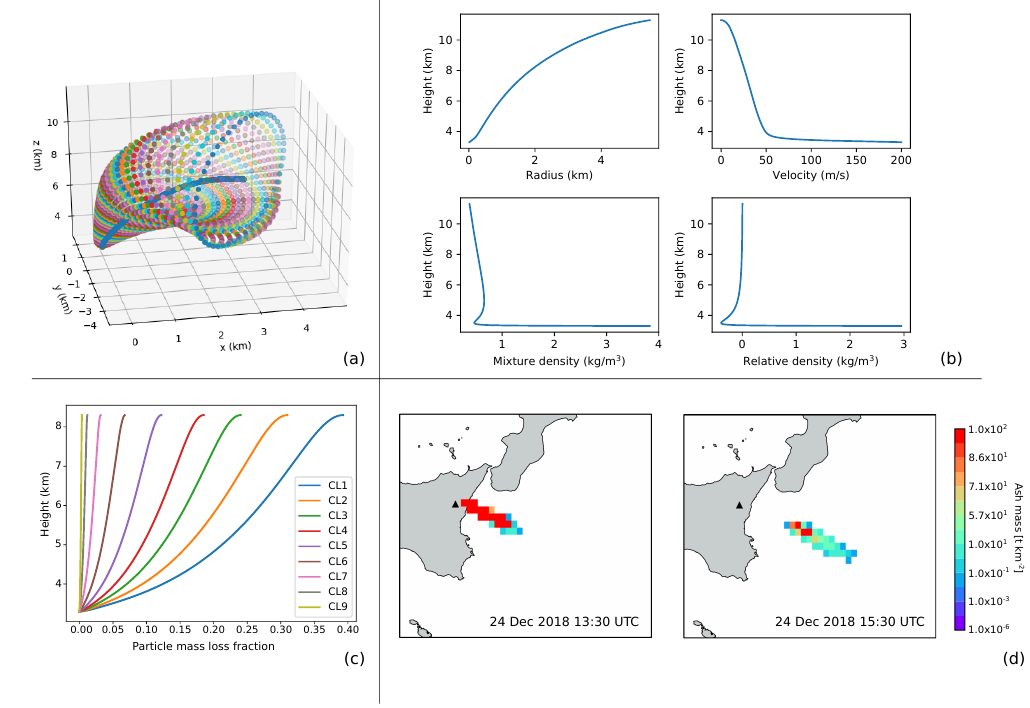
Figure 2. Results of a reference PLUME-MoM&HYSPLIT simulation. In Panels ( a – c ) the outcomes of PLUME-MoM are displayed, while Panel ( d ) presents the results of the HYSPLIT simulation initialized with the mass fluxes of particles computed by